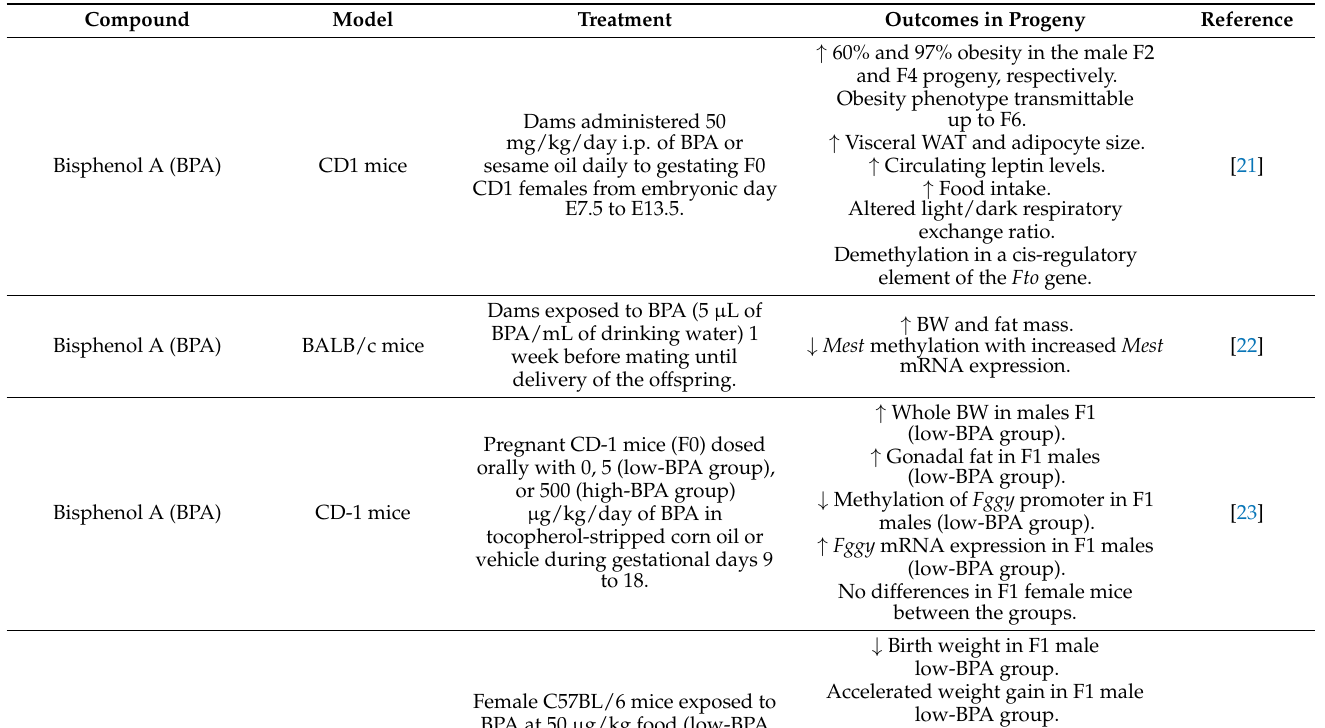
Table 1. Animal studies on transgenerational inheritance of obesity epiphenotypes after ancestral exposure to obesogenic non-persistent